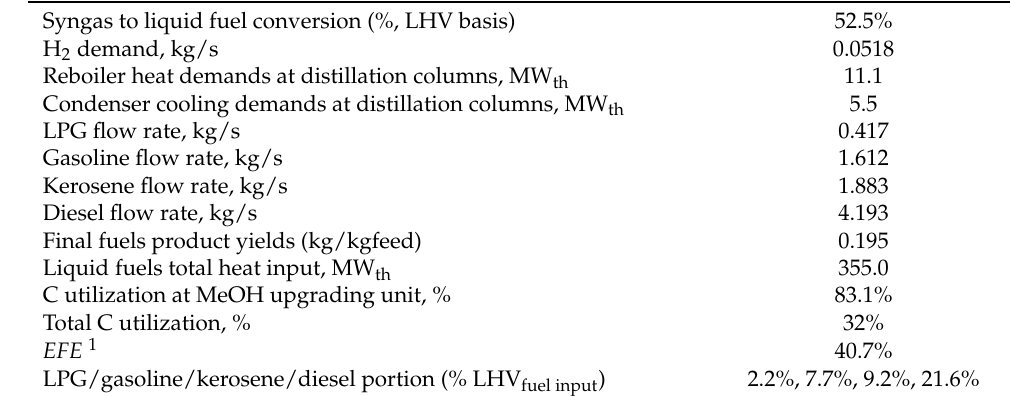
Table 10. Main process results from MTO-MOGD integration with the methanol plant (50/50